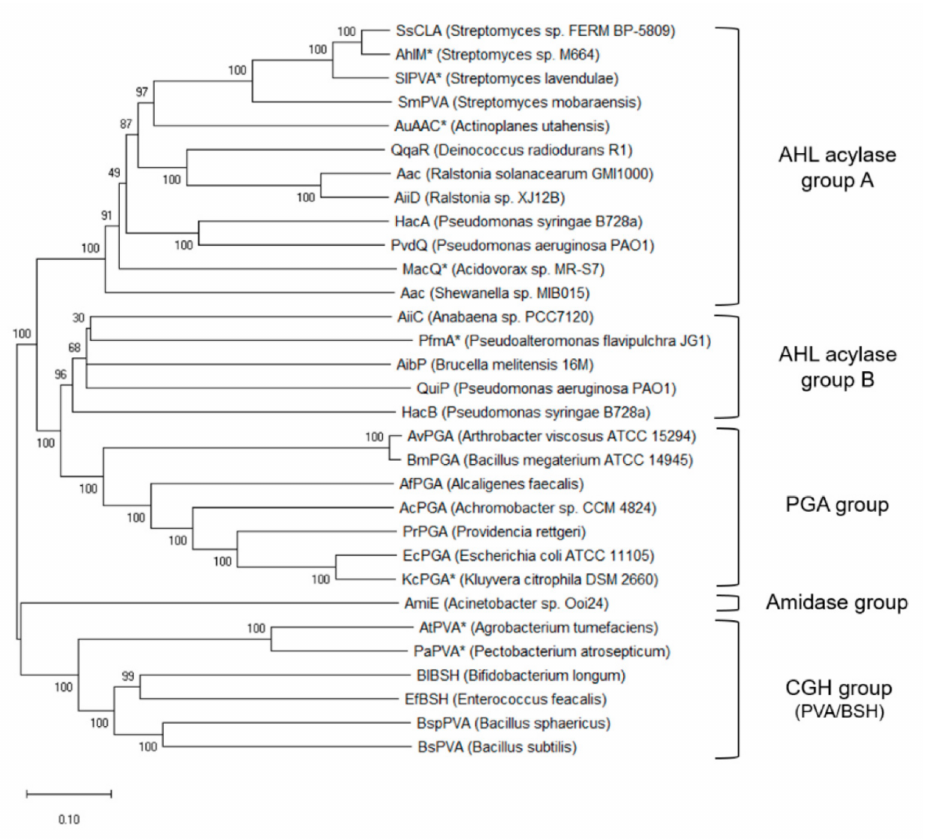
Figure 3. Molecular phylogenetic analysis of several members of the Ntn-hydrolase superfamily. Five clusters emerge correlating with substrate specificity: AHL acylase-like proteins are divided between two distinct clusters, AHL acylase group A and AHL acylase group B . The PGA group consists of penicillin G acylase proteins. The closely related bile salt hydrolase and penicillin V acylase proteins are grouped within the CGH group . A novel Amidase group was identified composed of an AHL acylase-like protein from Acinetobacter sp. Ooi24. Proteins that exhibit both AHL acylase and penicillin acylase activities are indicated by asterisks. The evolutionary history was inferred using the neighbour-joining (NJ) method within the 3DM and MEGA X packages. From